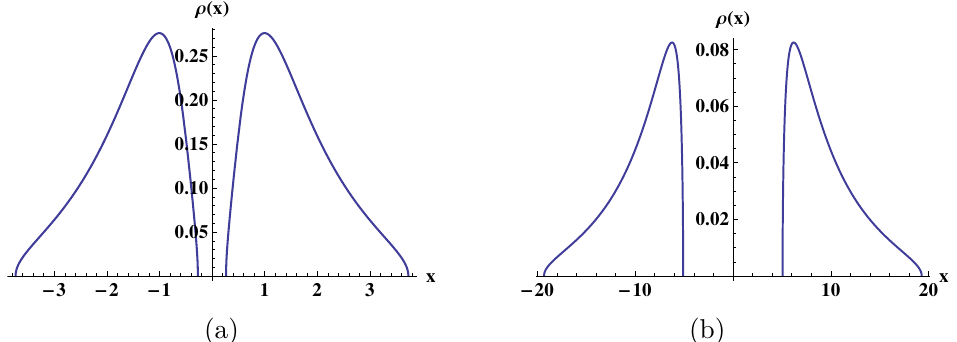
Figure 4 . The eigenvalue density in the two-cut case describing the supercritical regime κ > κ c . (a) τ = 2 , κ = 4 . (b) τ = 2 , κ = 100 , illustrating the asymptotic shape of the eigenvalue